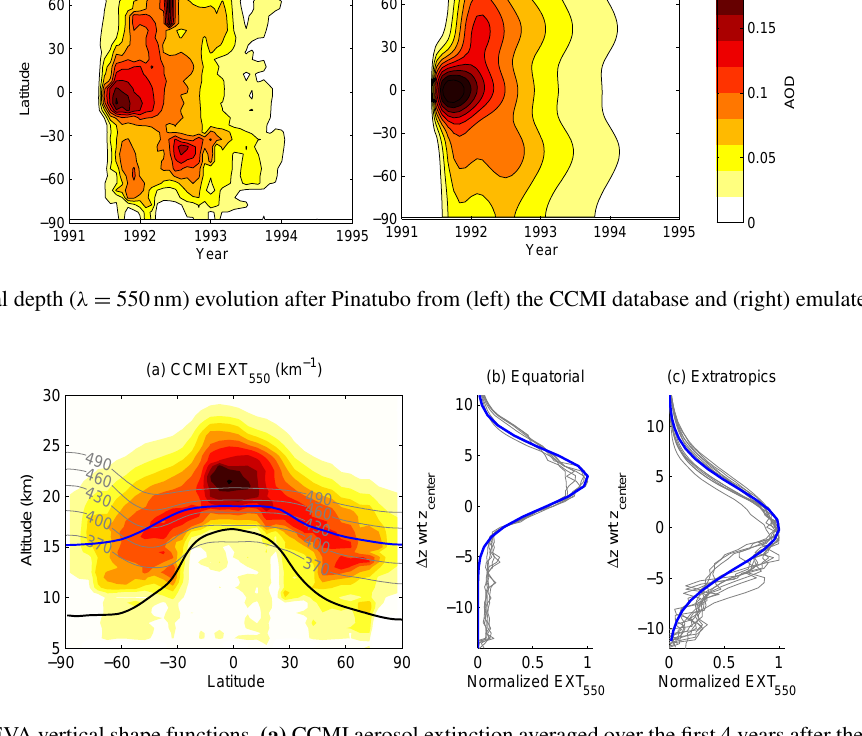
Figure 4. Definition of EVA vertical shape functions. (a) CCMI aerosol extinction averaged over the first 4 years after the Pinatubo eruption, as a function of latitude and height. The climatological tropopause is shown in black and climatological July potential temperature (K) surfaces shown in gray for values as labeled. The EVA vertical center line ( z center ) , as defined in text, is shown in blue. (b) Normalized CCMI 4-year post-Pinatubo average extinction profiles as a function of altitude with respect to the vertical center line for the tropical ( − 15 to 15 ◦ N) latitudes (gray), and the Gaussian fit defining the EVA vertical shape function for the equatorial plume (blue). Panel (c) is the same as (b) for extratropical (30–60 ◦ )